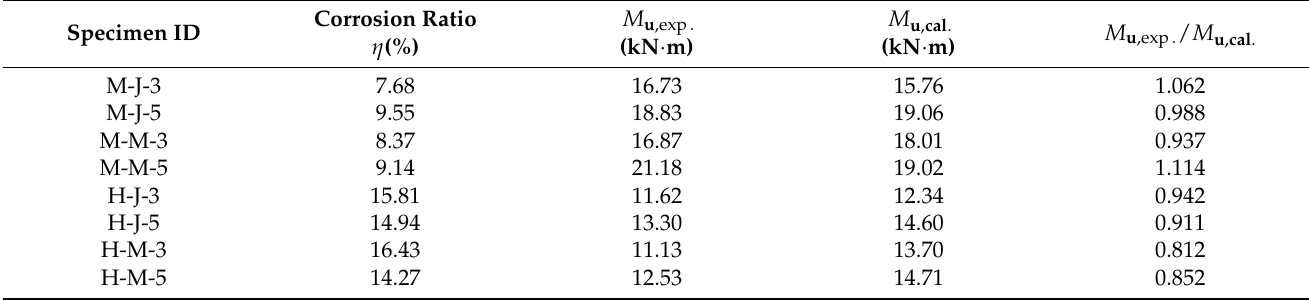
Table 8. Comparison of test and calculated results of specimen flexural